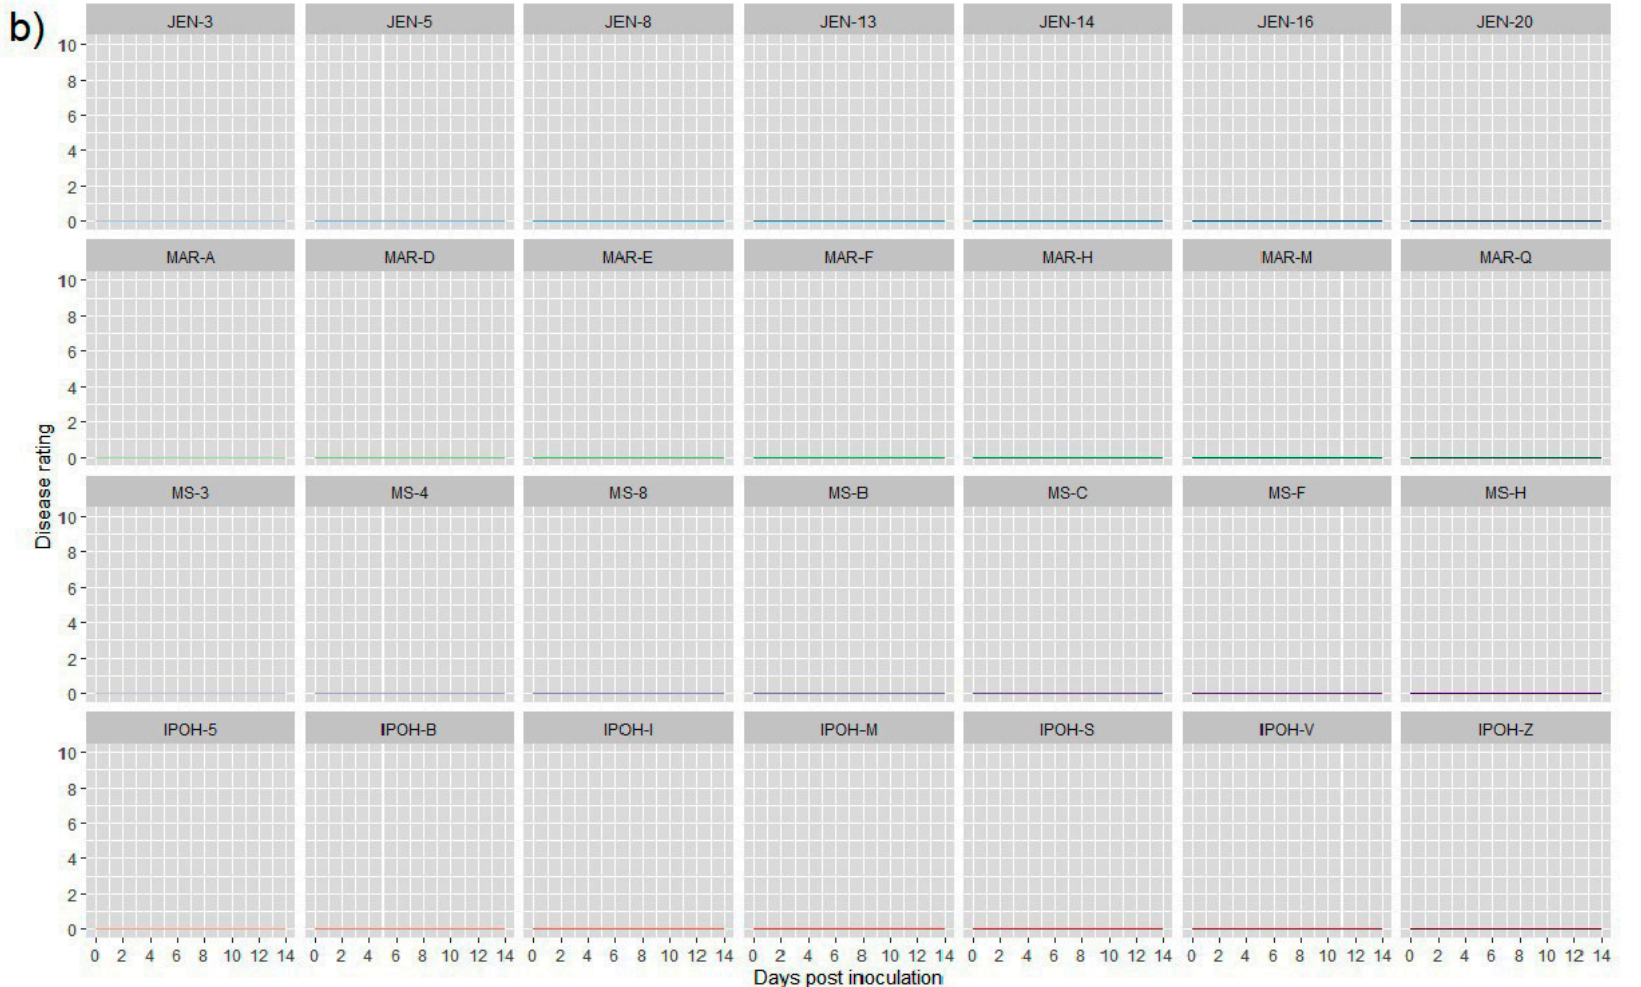
Figure 7. The median disease rating progression (0–4) of Pantoea stewartii subspecies stewartii ( n = 28) inoculated on sweetcorn seedlings at ( a ) nine weeks old and ( b ) two weeks old, within 14 days post-inoculation. The color ranges and columns displayed are based on collection areas: blue on the Jenderam isolates (column 1); green on the Maran isolates (column 2); purple on the Muadzam Shah isolates (column 3); and red on the Ipoh isolates (column 4).